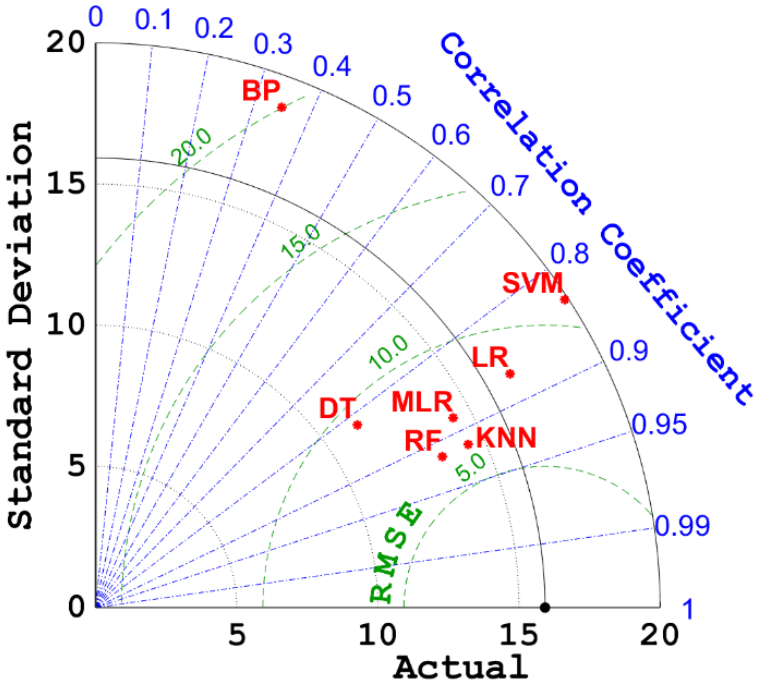
Figure 11. Taylor diagrams of test sets for different models.